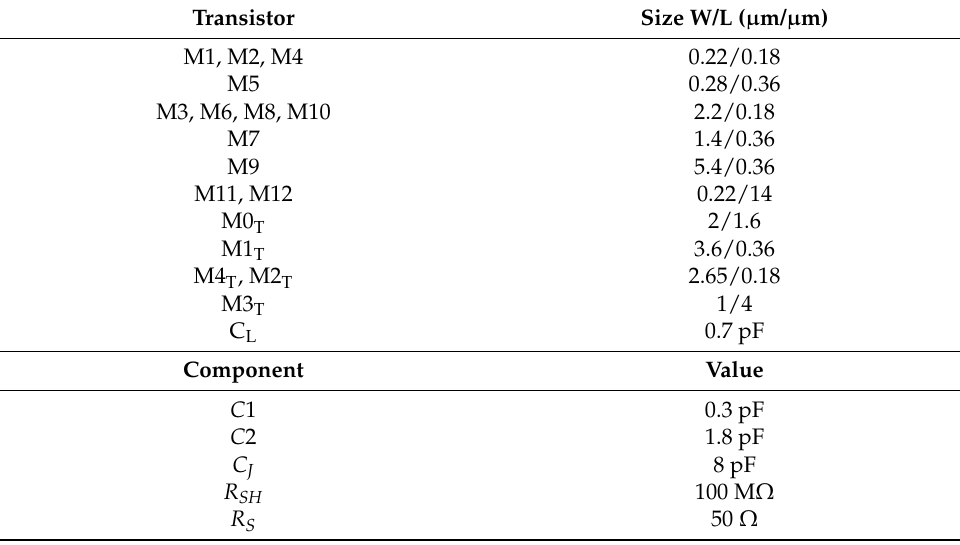
Figure 3. Layout of the CMOS optoelectronic circuit: ( a ) the TUNABLE CURRENT PRE-AMPLIFIER block; ( b ) the TIA block; and ( c ) the integrated PD based on a PNP junction. Table 1. Transistor sizes and values of the passive components of the electronic circuit.